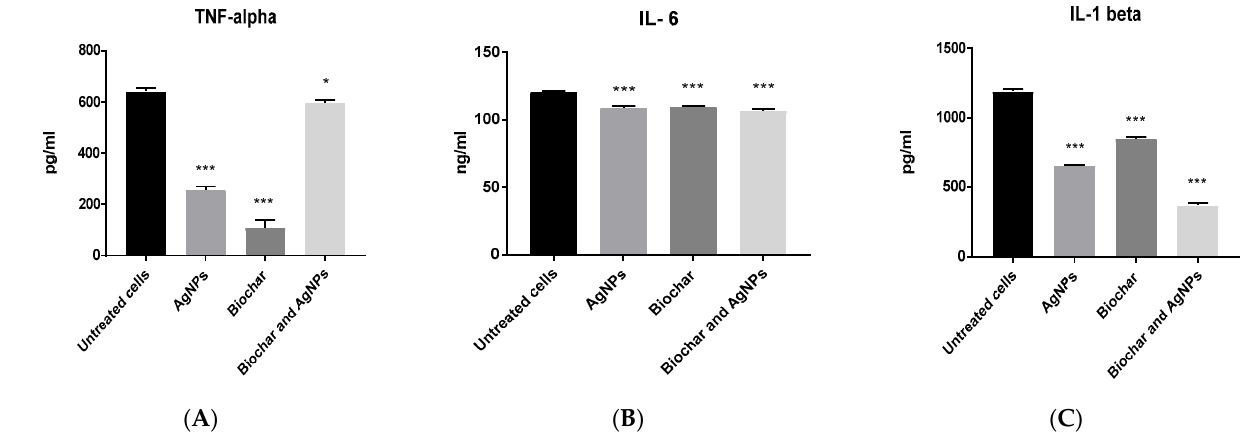
Figure 7. The effect of AgNPs at 6 µg/mL and biochar at 200 µg/mL on the expression of ( A ) TNF alpha, ( B ) IL-6 and ( C ) IL-1 beta using HT29 cell line in 72 h cultures. The results are expressed as means of three measurements ± SD ( n = 3–4 independent replicates), *: p < 0.05, ***: p < 0.001 compared to respective untreated cells.